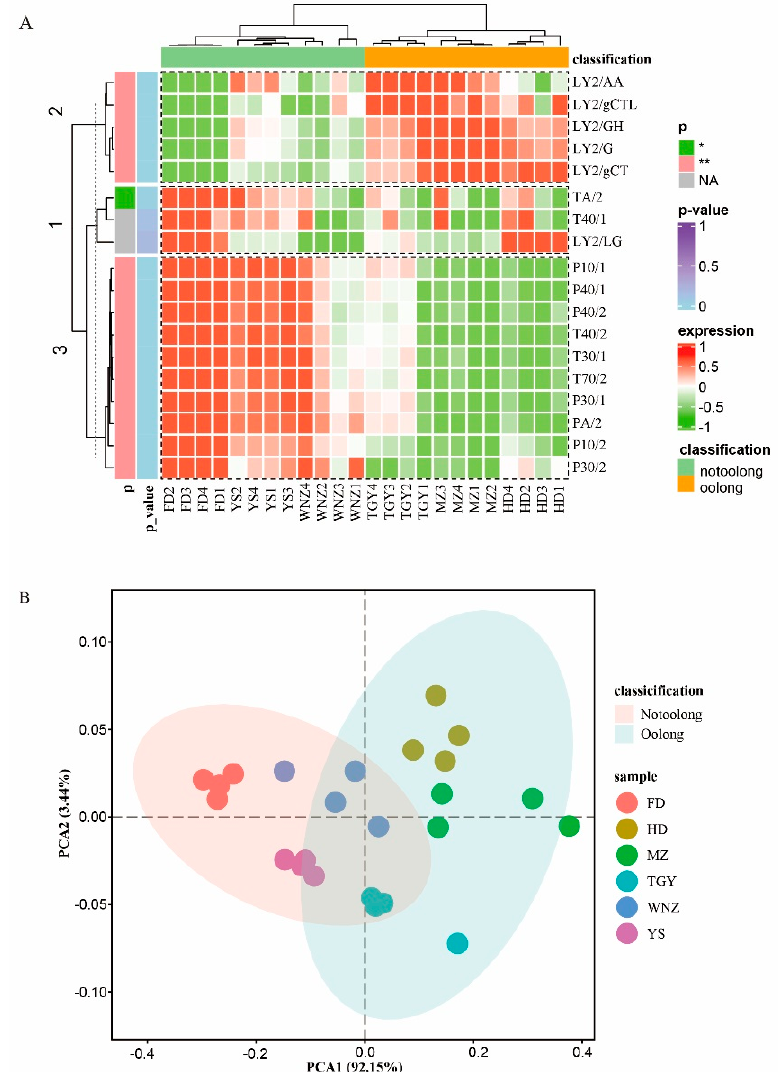
Figure 2. Stable response values of electronic nose sensors for samples of six different tea cultivars. ( A ) Heat map of electronic nose response values for samples of six different tea cultivars. ( p : signif- icant results based on Kruskal–Wallis test; “*” indicates p < 0.05; “**” indicates p < 0.01, and “NA” indicates p > 0.05. expression: the size of the response values of different samples to the same sensor. ( B ) The PCA analysis score plot of electronic nose response values for six different tea cultivars.